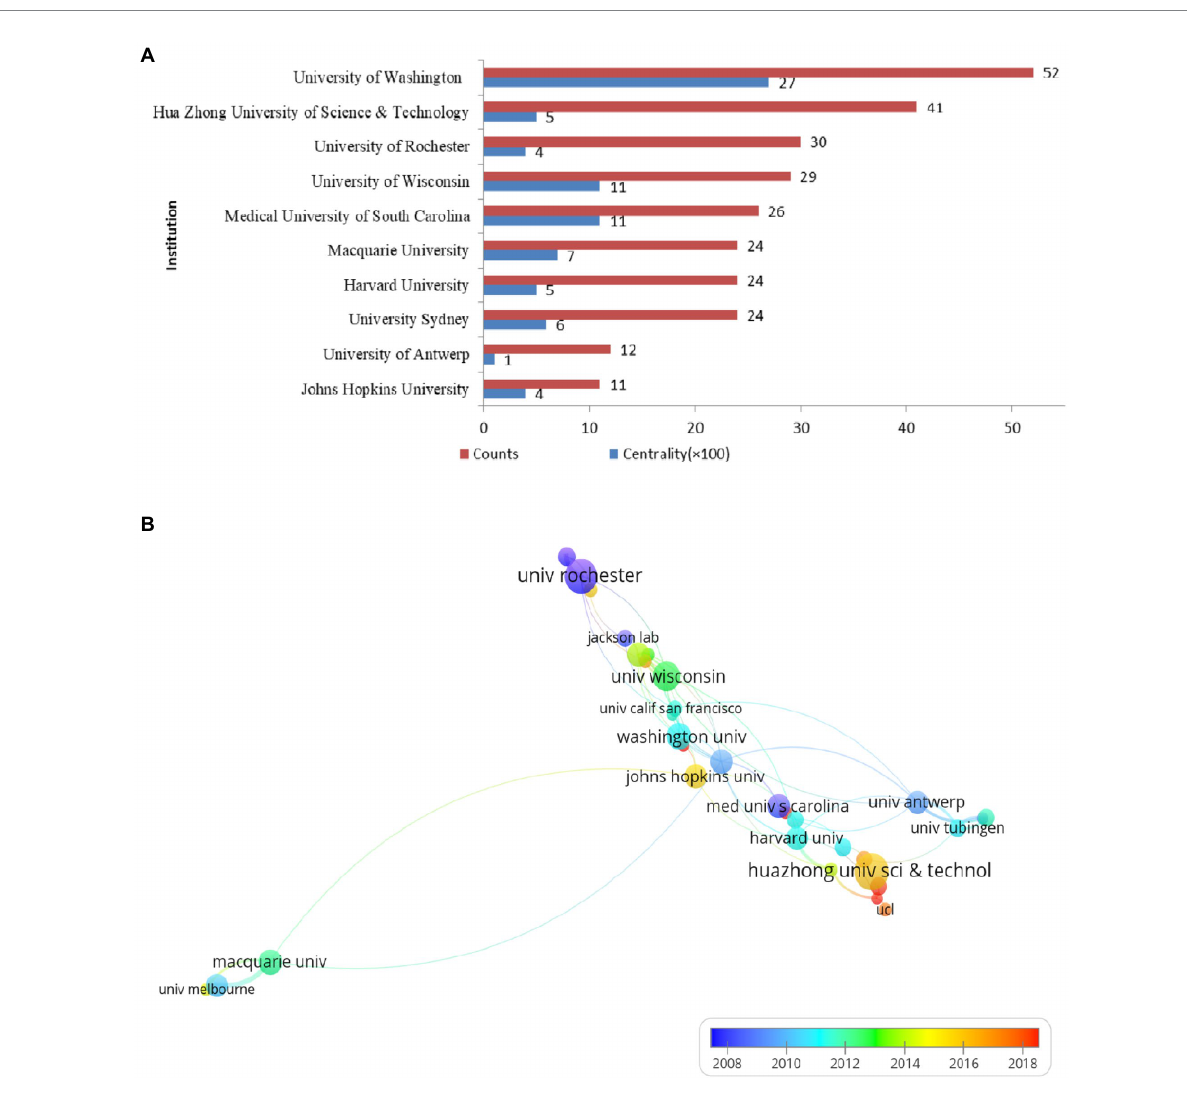
FIGURE 5 Top 10 institutions in terms of the number and centrality of studies published in 2002–2021 (A) and a network map of the institutions (B)